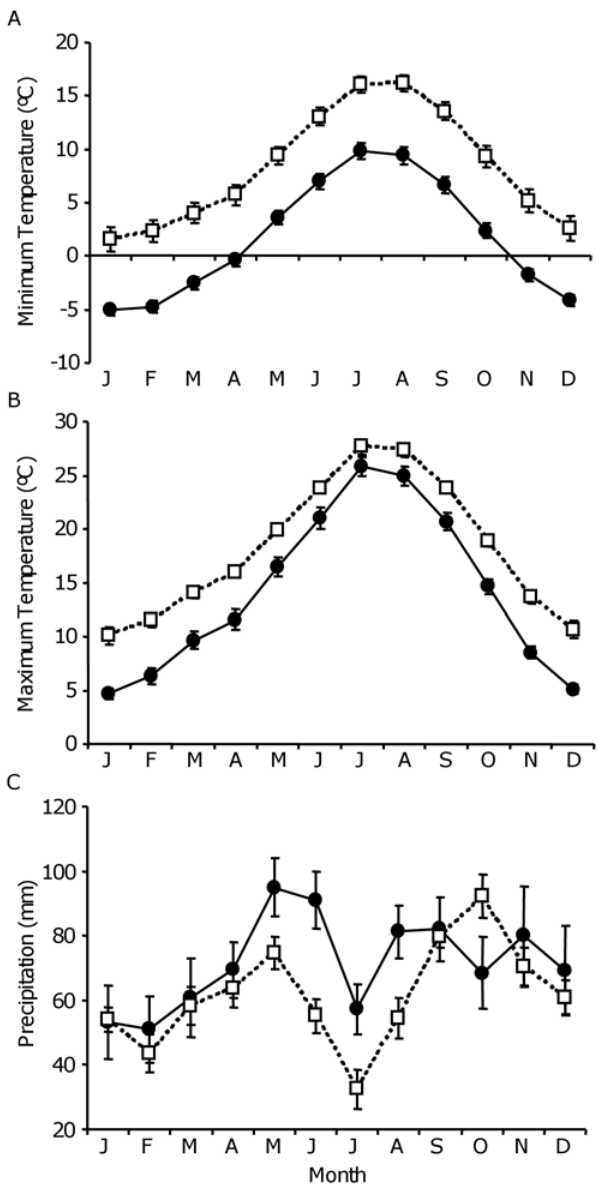
Figure 3. Climatic patterns for coastal and montane regions. The three panels show mean ( 6 SE) values of (A) monthly minimum temperature, (B) monthly maximum temperature, and (C) monthly total precipitation for montane (filled dots) and coastal (hollow cuadrats) populations.